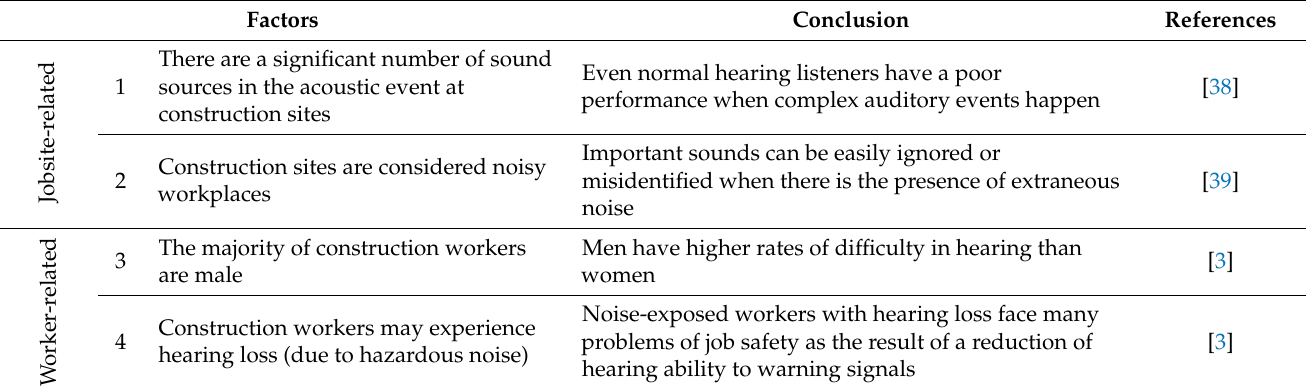
Table 2. Summary of factors causing the decline in auditory situational awareness of construction workers. Factors